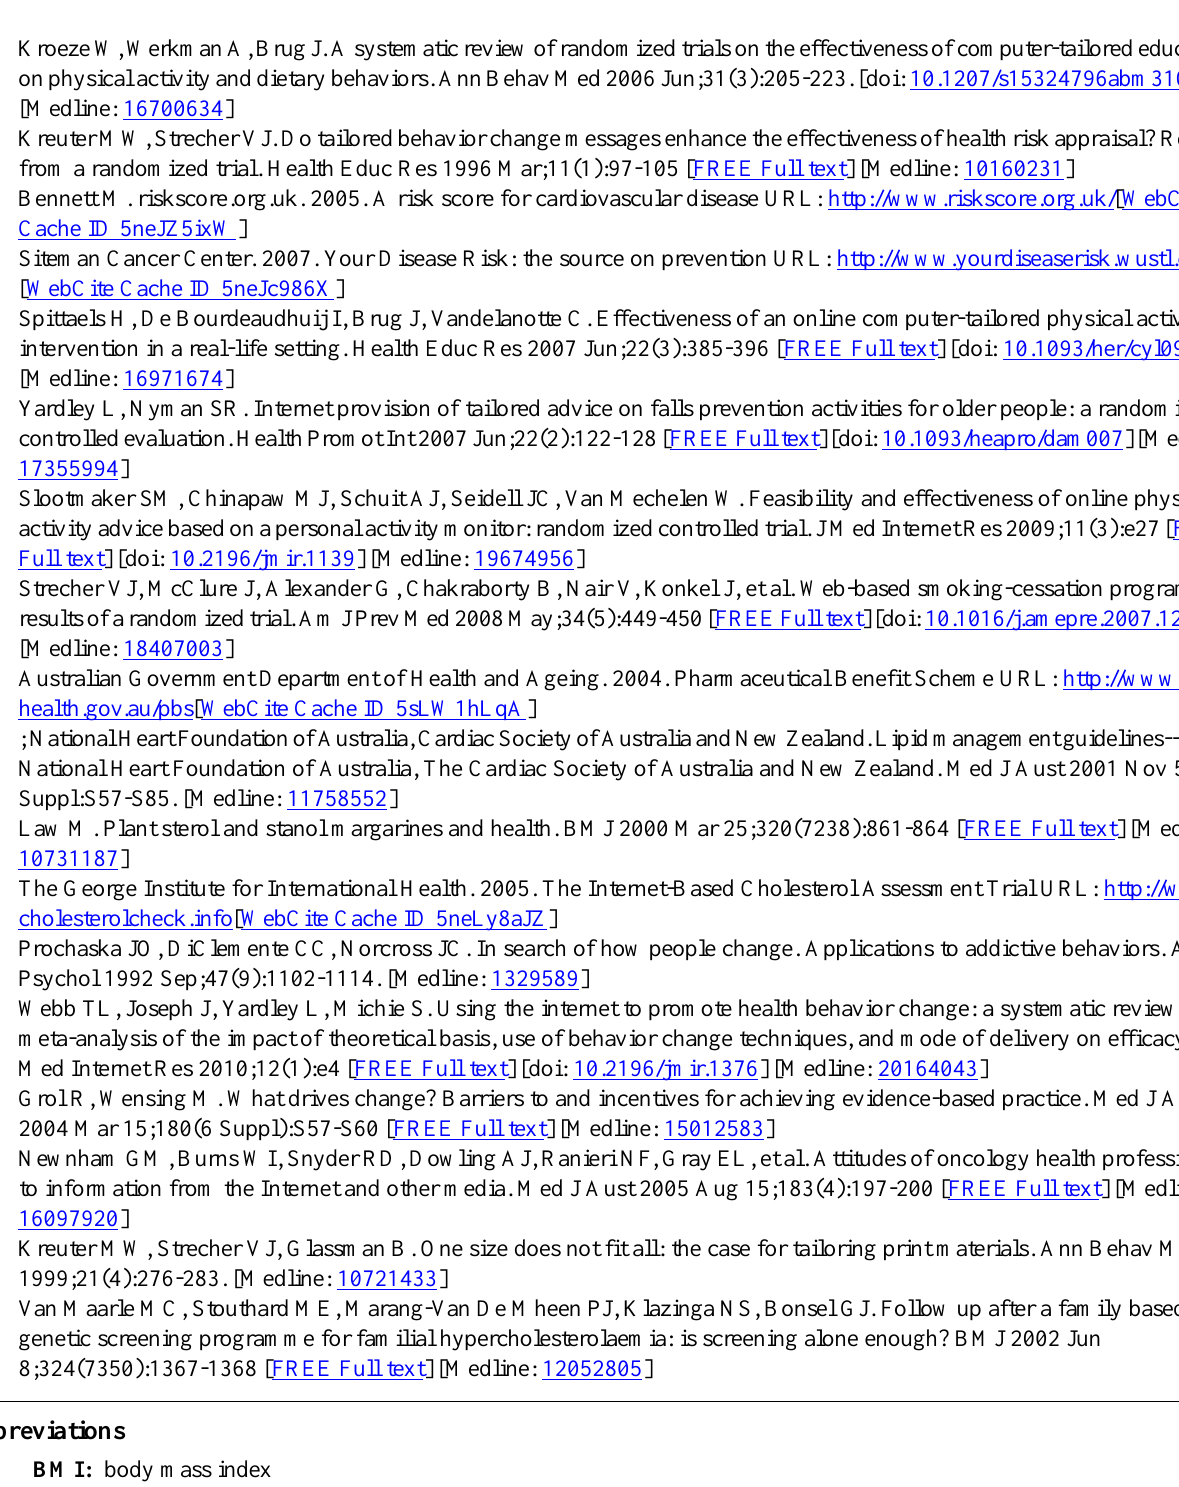
BMI: body mass index I-CAT: Internet-based Cholesterol Assessment Trial HDL: high-density lipoprotein LDL: low-density